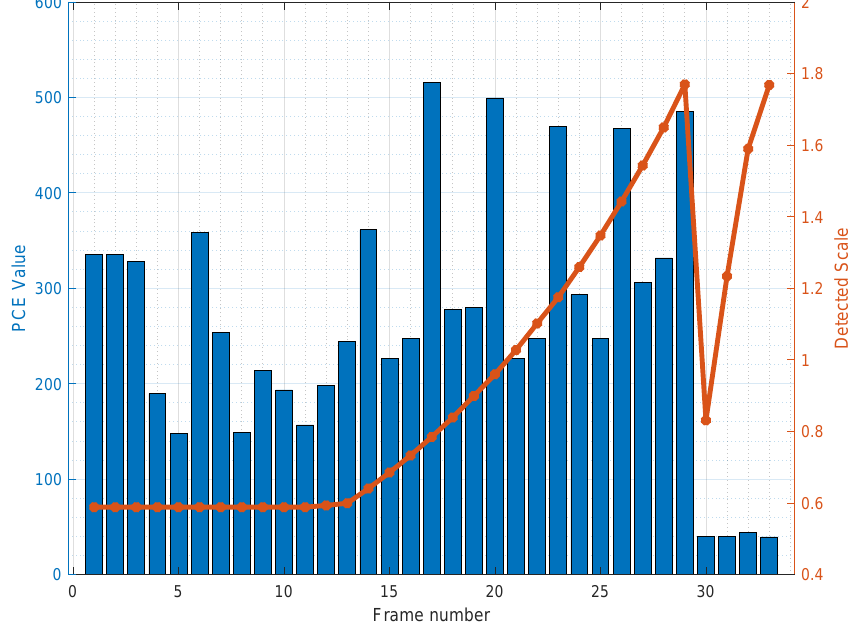
Figure 10. Detected scale factor, and corresponding Peak-to-Correlation Energy ( PCE ) value, for a video captured increasing the digital zoom from roughly half the video